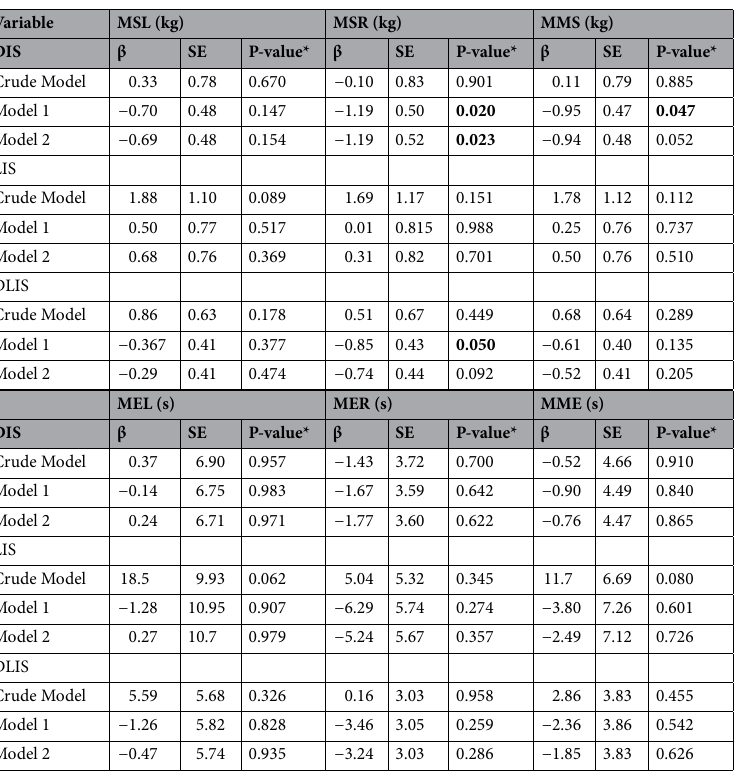
Table 4. Association of dietary inflammation score (DIS), lifestyle inflammation score (LIS), and the dietary and lifestyle inflammation score (DLIS) with muscle strength, and muscle endurance. MMS, Mean muscle strength; MSL, Muscle strength of left hand, MSR; Muscle strength of right hand, MME, Mean muscle endurance; MEL, Muscle endurance of left hand, MER; Muscle endurance of right hand. Data were obtained from the Multiple linear regression. Model 1 is adjusted for age, sex, energy intake, marriage status, occupation, and education status. DIS was adjusted further for body mass index, physical activity, and smoking status. Model 2 is adjusted for age, sex, energy intake, socio-economic status score (SES) including: marriage status, occupation, and education status. DIS was adjusted further for body mass index, physical activity, and smoking status. P < 05.0 is significant. P = 05.0 is marginally significant. Significant values are in